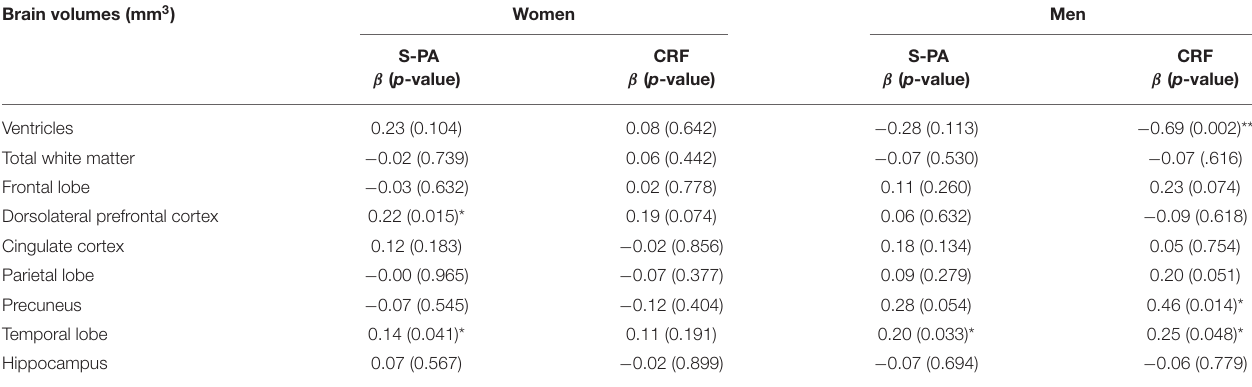
TABLE 3 | Linear regression models in women and men: relationship between physical activity variables and brain